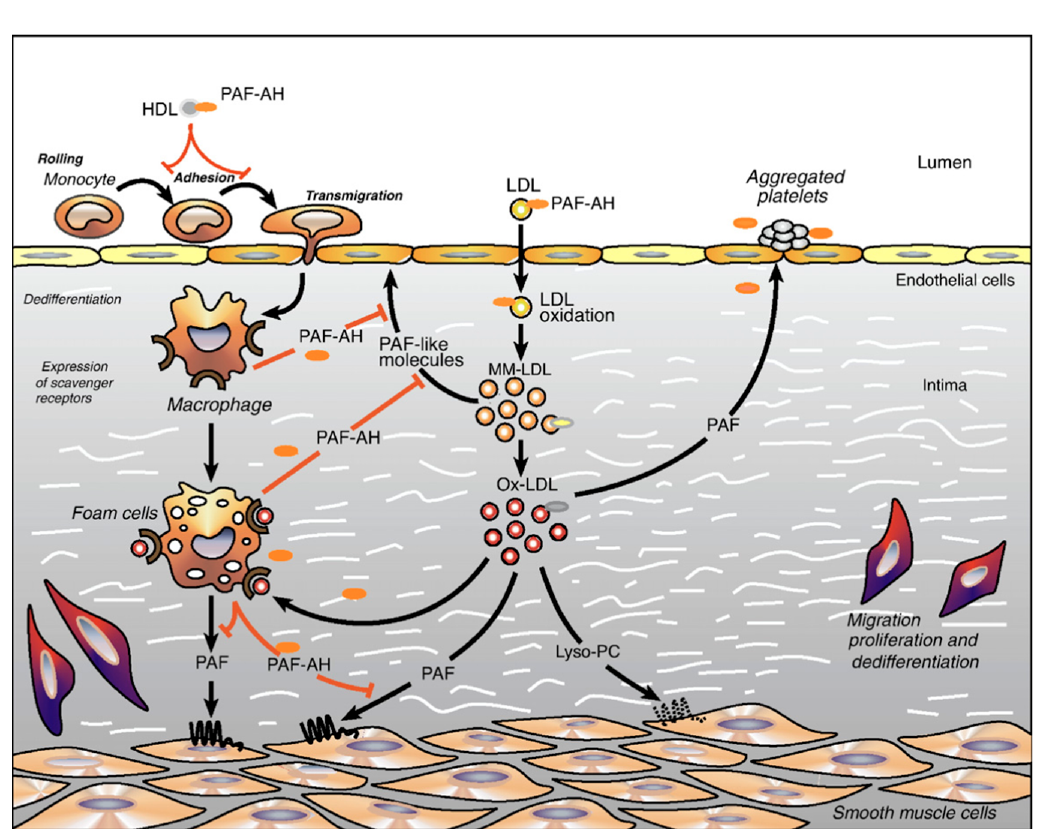
Figure 3. Relationship between PAF and atherosclerosis [30].